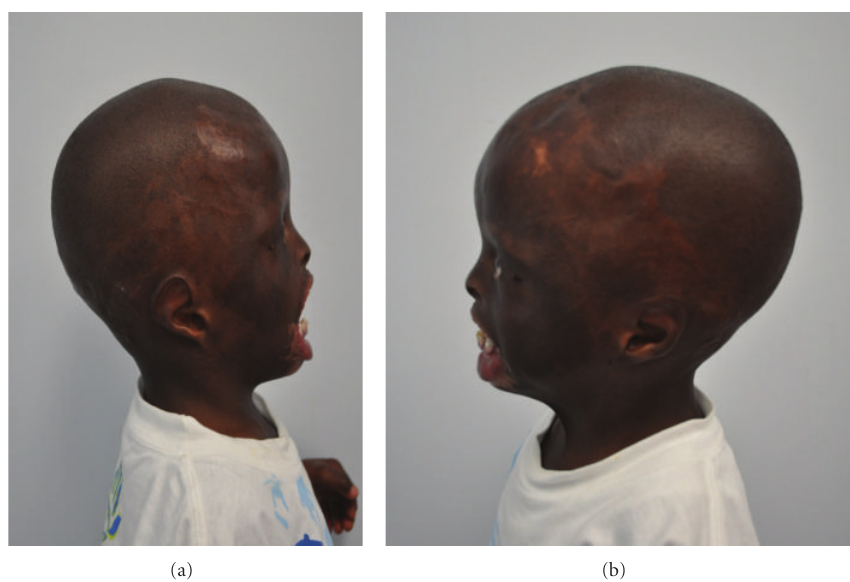
Figure 2: Hypoplastic ears fused to head, underdeveloped nose, and